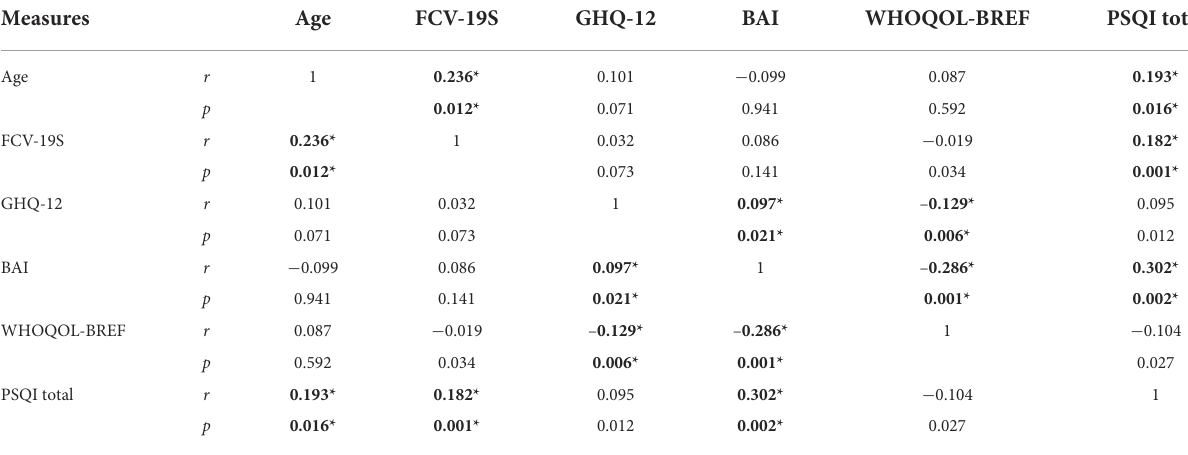
TABLE 7 Correlation analysis between our suggested measures (full sample).